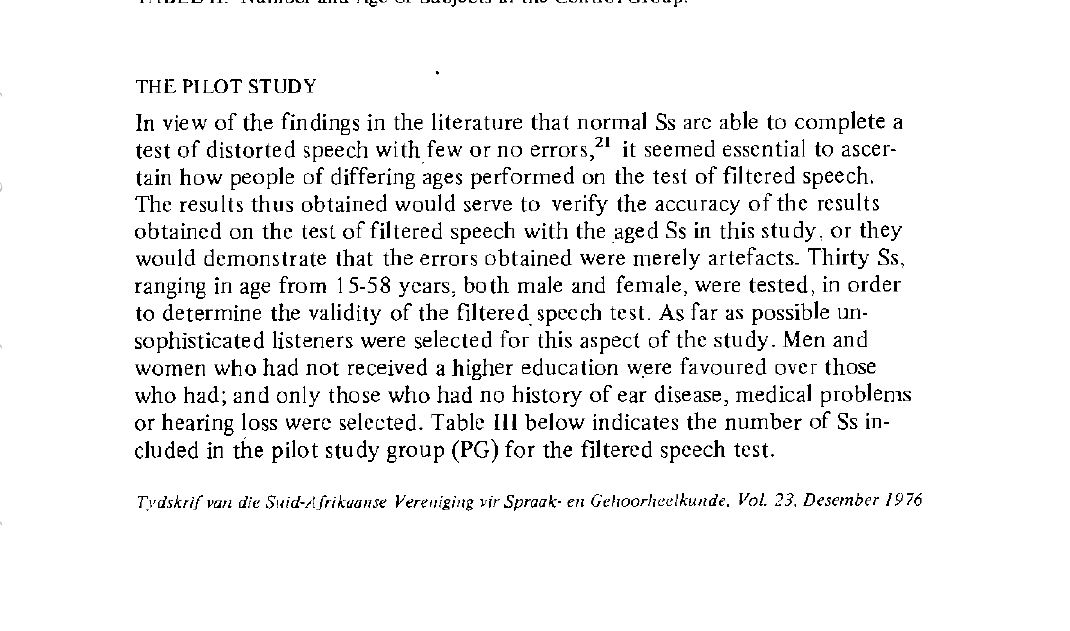
TABLE II. Number and Age of Subjects in the Control